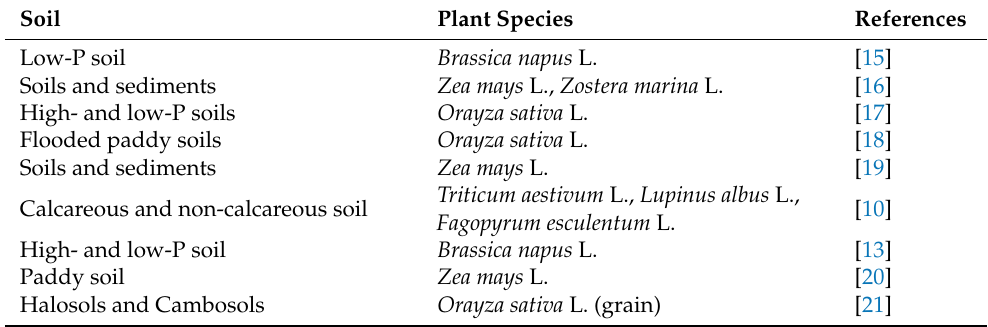
Table 1. Publications on the diffusive gradients in thin films technique (DGT) over the period